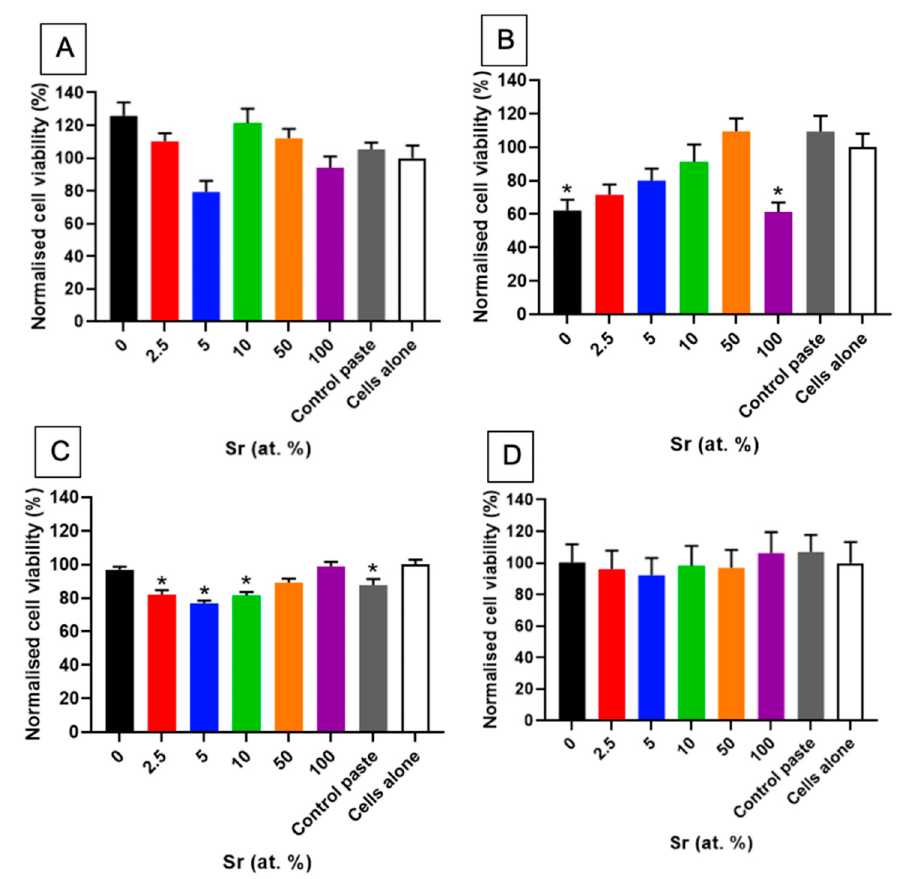
Figure 9. PrestoBlue ® viability assay results for MG63 cells cultured directly for 48 h with SrHA (0, 2.5, 5, 10, 50 and 100 at.% Sr) pastes ( A ) or gels ( B ) or indirectly for 24 h with SrHA pastes ( C ) or gels ( D ). ReproBone ® novo used as control paste alongside cells with no material present ( n = 9). Error bars ± standard error of the mean. Significance level compared to cells alone control * p < 0.05.